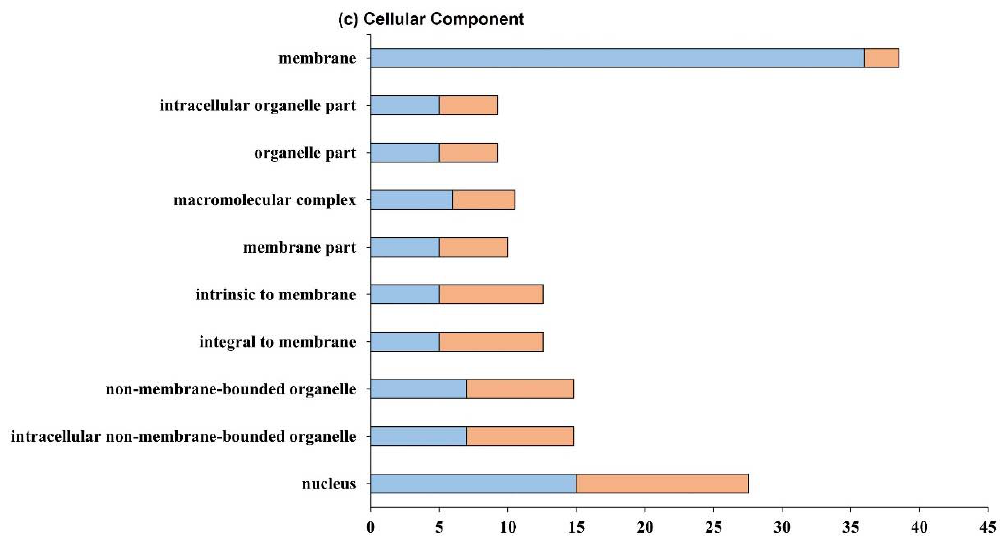
Figure 4. Gene ontology annotation of the QTL target locus RM6235–RM24288 on chromosome 9. ( a ) The 20 top ‐ ranking GO terms for Biological Process. ( b ) The 20 top ‐ ranking GO terms for Molecular Function. ( c ) The 10 top ‐ ranking GO terms for Cellular Component.